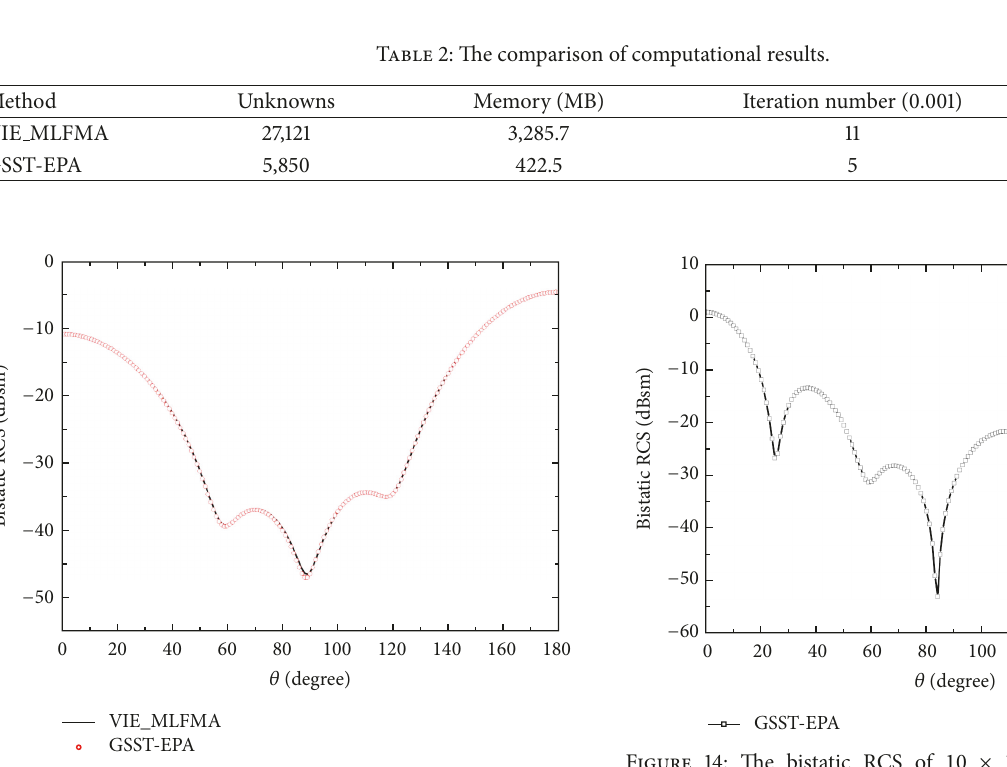
Figure 13: The bistatic RCS of 5×5 pyramid array; HH polarization at 1.0 GHz.